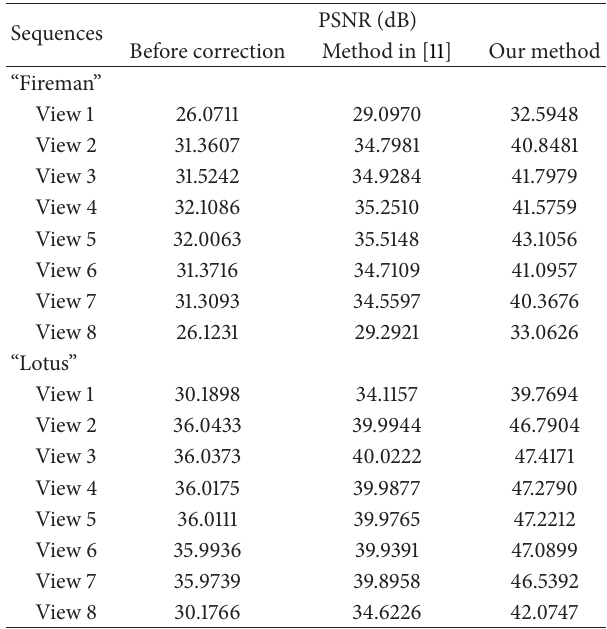
Table 1: Crosstalk reduction results (PSNR) comparison in two